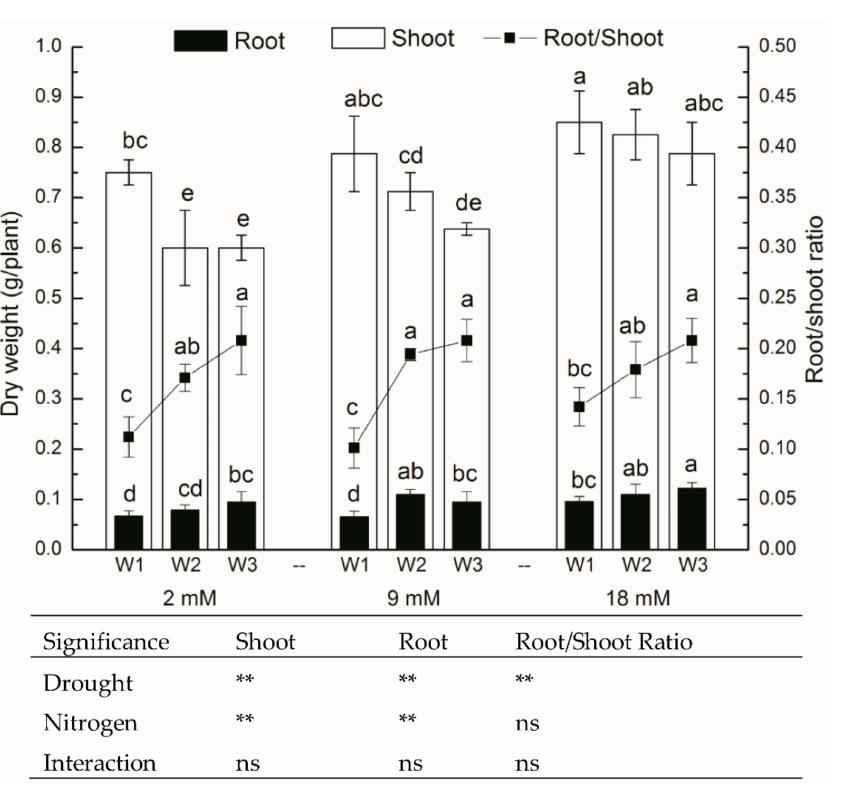
Figure 2. Shoot biomass and root biomass (bars) of pakchoi at the end of the experiment. Root/Shoot ratio is also represented (continuous line). W1: 0 g · L − 1 PEG 6000, blank; W2: 60 g · L − 1 PEG 6000, mild drought stress; W3: 120 g · L − 1 PEG 6000, moderate drought. For the dry weight of shoot and root, bars with the different letters indicate significant difference ( p < 0.05). For Root/Shoot ratio, lines with the different letters indicate significant difference ( p < 0.05). Error bars represent the standard deviation. p -values of the ANOVAs of drought, nitrogen supply, and their interaction are indicated. ns, not significant. ** p <